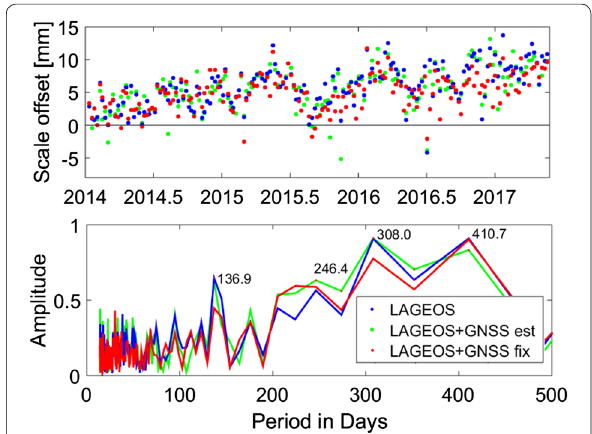
Fig. 8 The scale difference in mm from the Helmert transformation of SLR solutions with respect to the